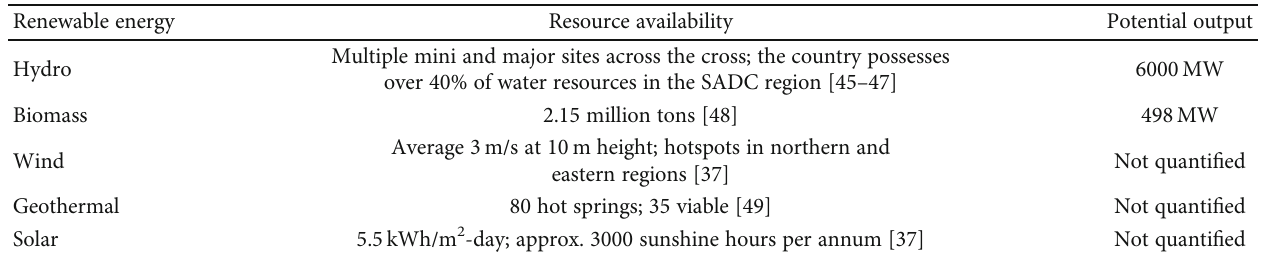
Figure 4: Global horizontal irradiation in Zambia [39]. Table 1: Renewable energy potential in